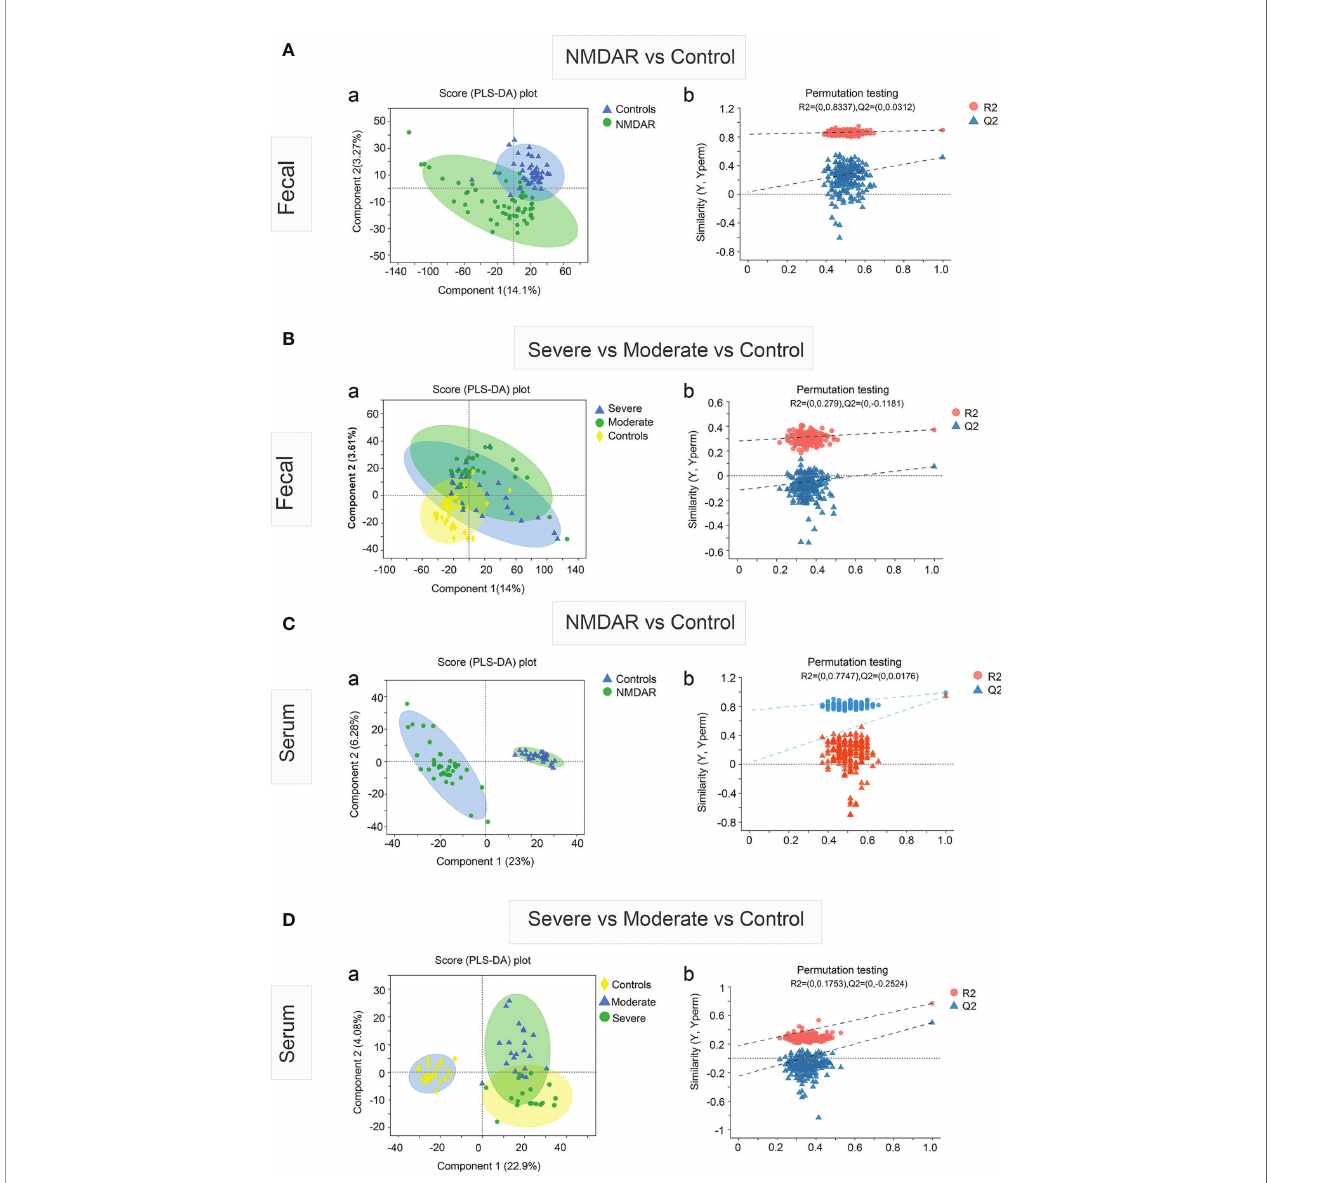
FIGURE 4 | Partial least squares discriminant analysis (PLS-DA) of the fecal and serum metabolomes in anti- N -methyl- D -aspartate receptor (NMDAR) encephalitis cases versus healthy controls. Fecal (A) and serum (C) metabolomics PLS-DA score plot of NMDAR encephalitis cases ( blue ) vs. controls ( green ). Each dot denotes an individual subject. Permutation test for the PLS-DA model: 999 permutations led to intercepts of R 2 = 0.833, Q2 = 0.03 (fecal) and R 2 = 0.774, Q2 = 0.017 (serum), implying an acceptable model minus over fi tting. Fecal (B) and serum (D) metabolomics PLS-DA score plot of NMDAR encephalitis cases with severe status ( blue ) and moderate status ( green ) versus controls ( yellow ). Each dot represents an individual subject. PLS-DA model permutation test: 999 permutations led to intercepts of R 2 = 0.279, Q2 = − 0.118 and R 2 = 0.175, Q2 = − 0.252, implying an acceptable model minus over fi